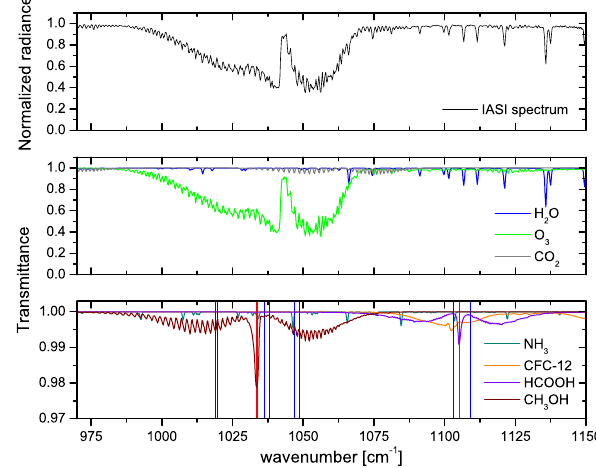
Fig. 1. Top panel: IASI normalized radiance spectrum in the spec- tral region between 950 and 1200cm − 1 containing methanol and formic acid absorption bands. Bottom panels: Contribution to the IASI spectrum of different atmospheric species plotted in transmit- tance. The vertical lines indicate the target channels (in red) and the baseline channels (in blue) which are used for the 1T b determina- tion (nine channels are used for CH 3 OH, and three for HCOOH). See Sect. 2.2 for